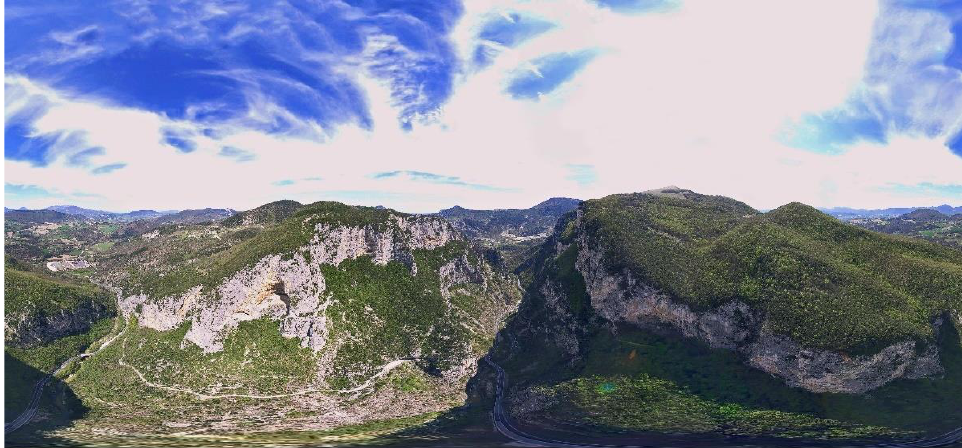
Figure 2. Panoramic view of the Frasassi gorge at 360°, captured by the drone used for 3D virtual